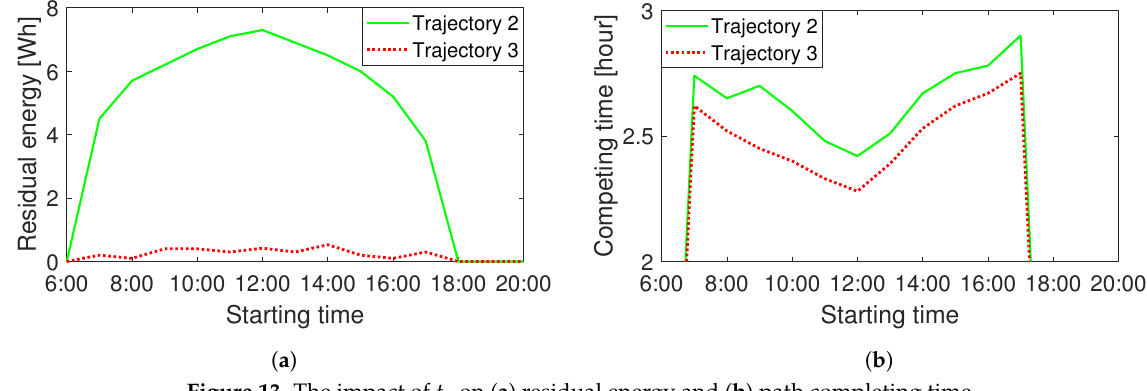
Figure 13. The impact of t 0 on ( a ) residual energy and ( b ) path completing